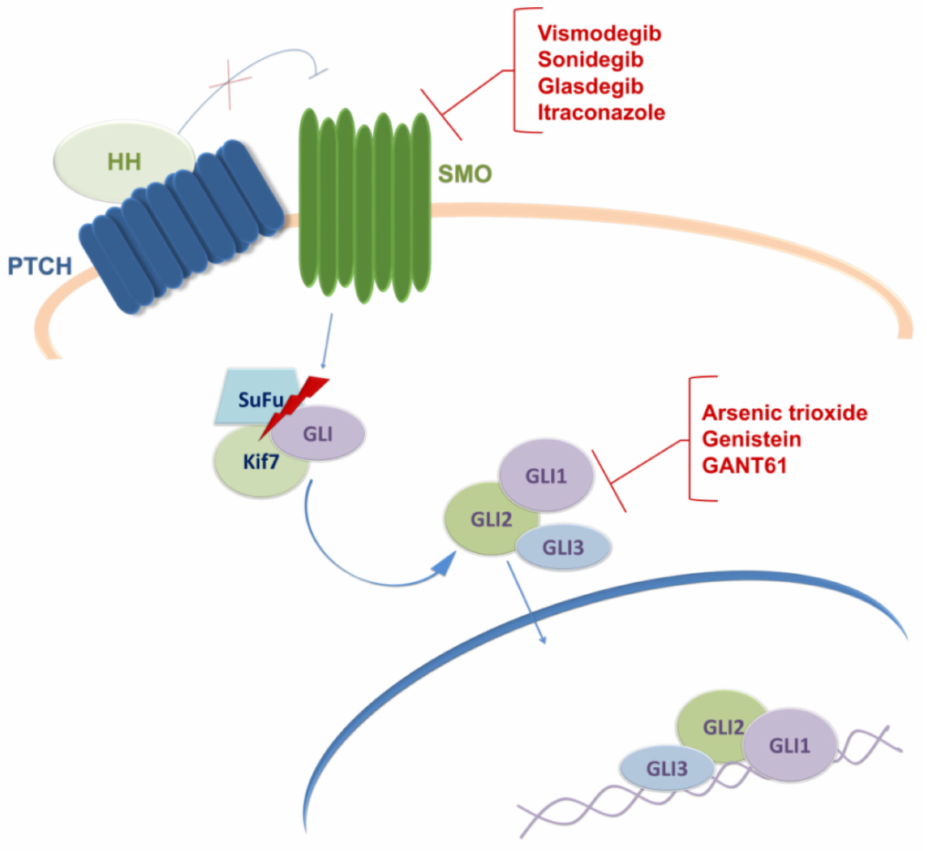
Figure 2. The canonical activation of HH pathway and its pharmaceutical inhibitors. The activation of pathway occurs when HH ligand binds to PTCH at the cell membrane. In response to this binding, PTCH no longer inhibits SMO and initiates the downstream signaling, causing rapid dissociation